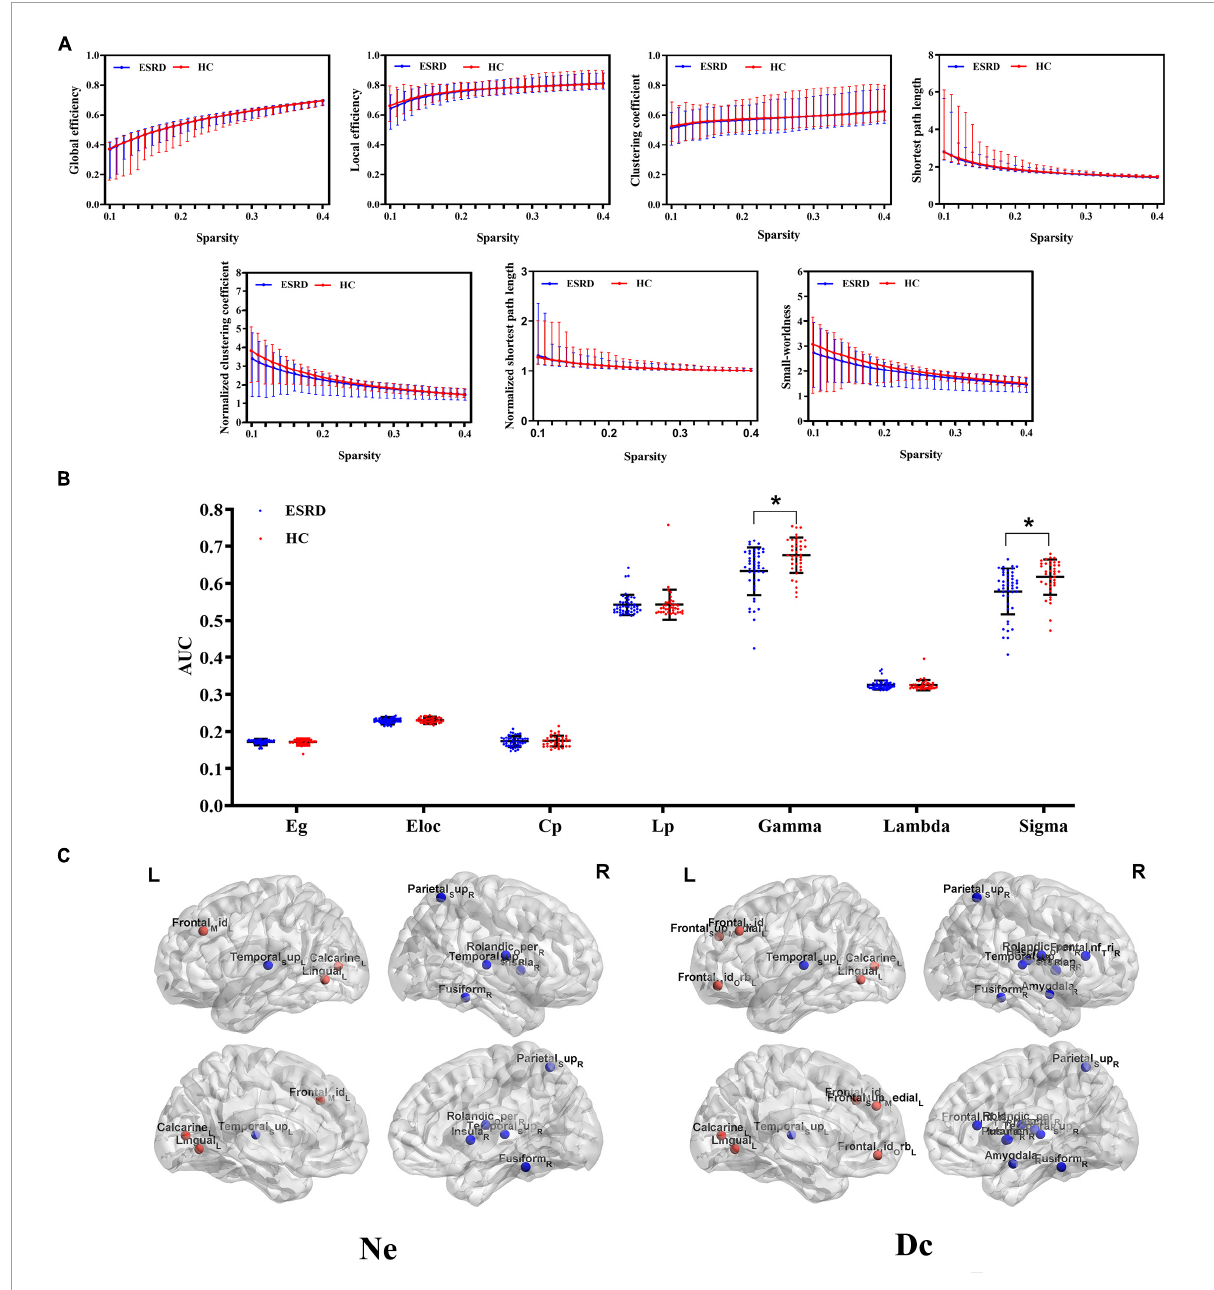
FIGURE3 Functional networks. (A) Global topological measures of the whole-brain functional network were demonstrated within a whole range of sparsity values (0.1–0.4). Both groups exhibited small-world properties, with γ > 1, λ ≈ 1, and σ > 1; (B) Between-group differences of global topological measures of the functional network. The bottom dot-plots represent individual data points, averages (transverse line), and standard deviation (vertical lines). Healthy controls are shown in red, and ESRD patients are shown in blue; (C) Three-dimensional cerebral maps of nodal efficiency and nodal degree centrality. Red dots indicate brain regions with increased nodal parameters, and blue dots indicate brain regions with decreased nodal parameters.